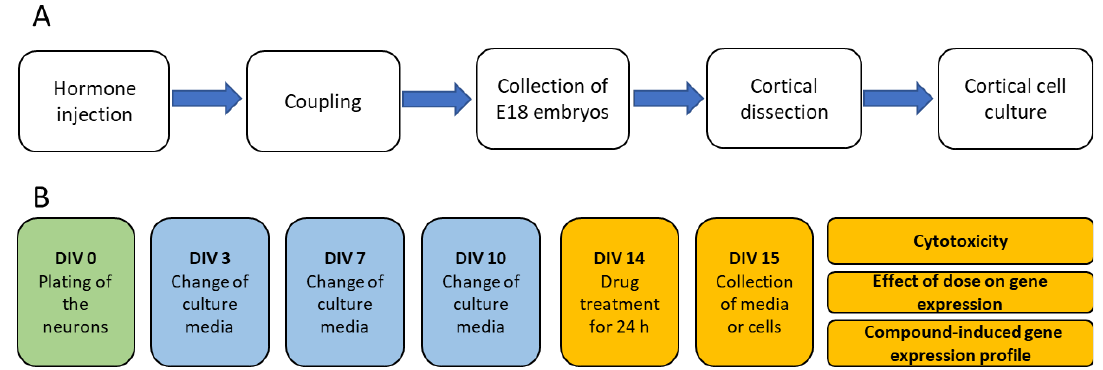
Figure 6. Production of embryos and set-up of cell cultures. ( A ) Production of embryos for the rat primary cortical cell cultures. ( B ) Treatment of cell cultures for the assessment of compound-induced cytotoxicity, dose-optimization, and compound-induced gene expression.